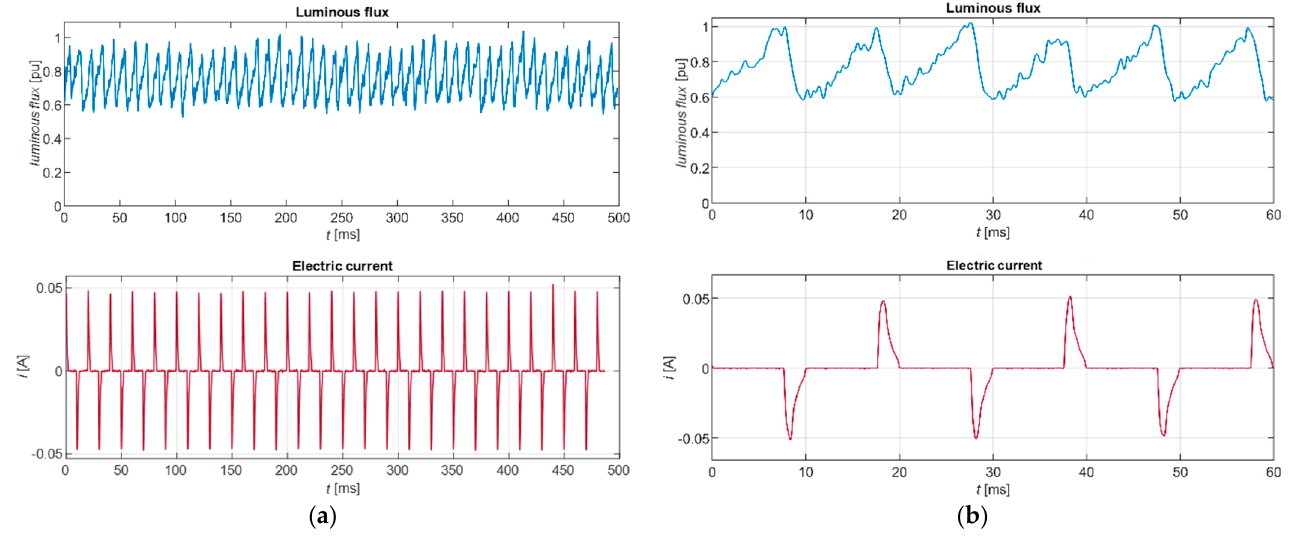
Figure 18. Time course of the luminous flux and electric current: ( a ) Time course up to 500 ms; ( b ) Time course up to 60 ms.